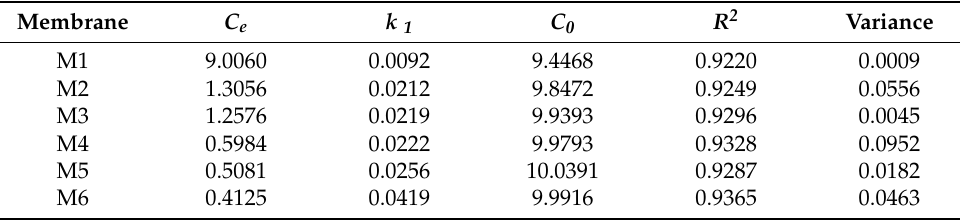
Table 7. Estimated parameter values of the PFO models by the numerical calculations for the extraction process with different percentages of the carrier (B 2 EHP).